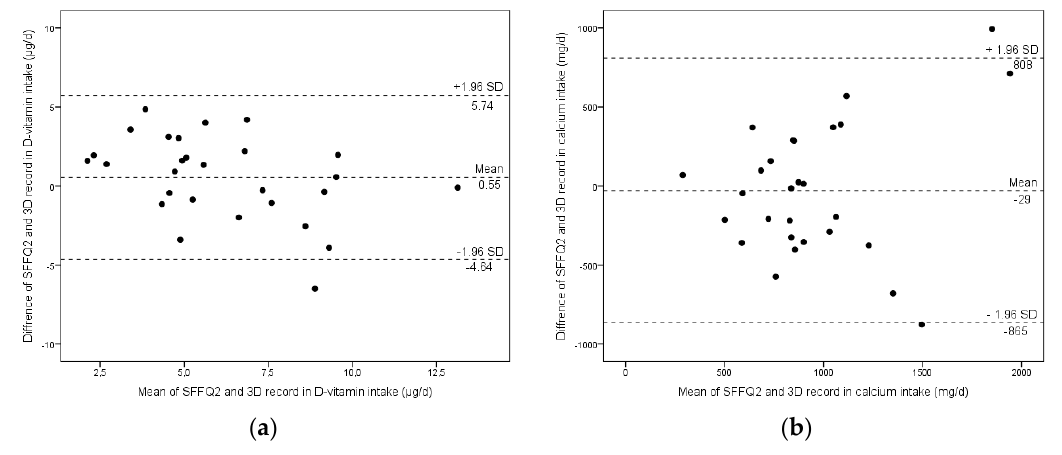
Figure 1. Bland-Altman plots show the mean difference and limit of agreement for vitamin D ( a ) and calcium ( b ) between short food frequency questionnaire 2 (SFFQ2) and the three-day food record (3D record) assessed in 28 5–7-year-old children from northern Sweden.